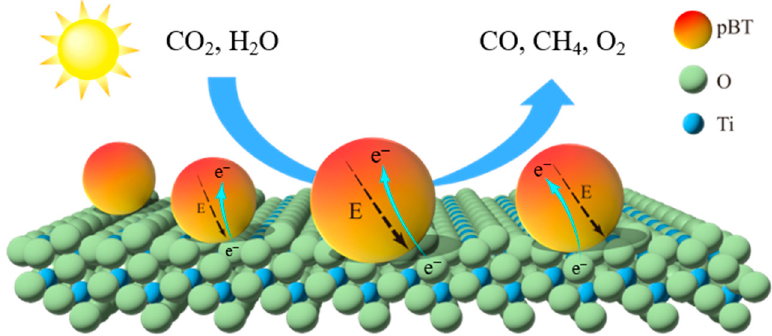
Figure 7. Enhancement mechanism for CO 2 photoreduction over pBT/P25 upon light irradiation.